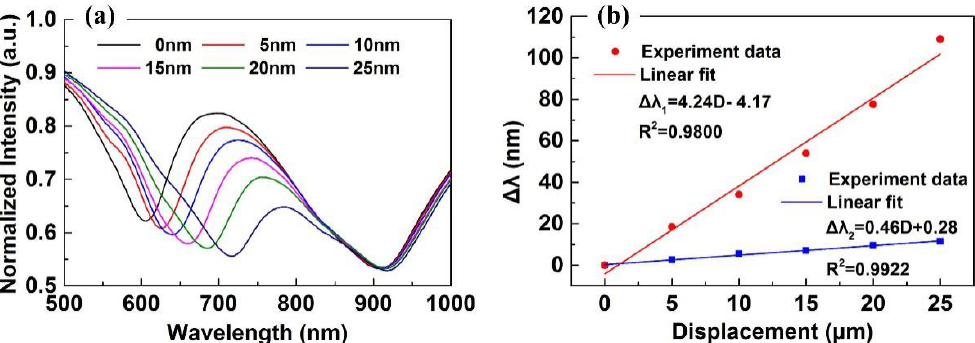
Figure 8. ( a ) The experimental surface plasmon resonance (SPR) spectrum changing with D ; ( b ) the